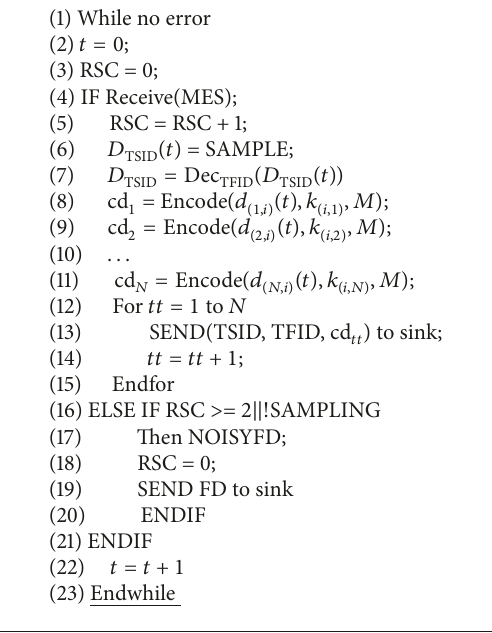
Algorithm 2: Subnode really sample and generate interference